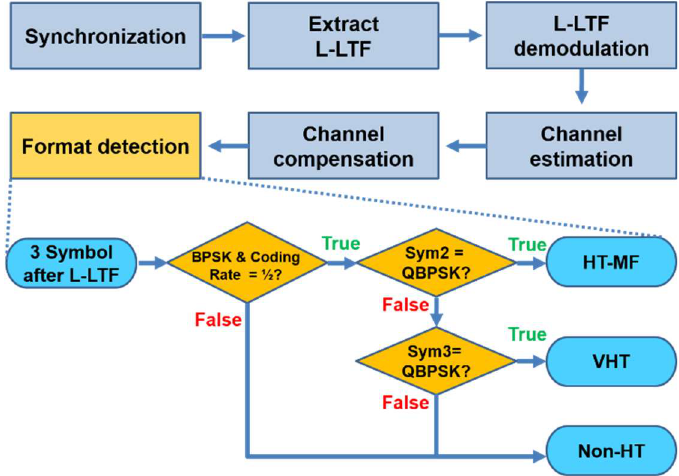
Figure 3. Flowchart of the conventional frame format detection procedure.